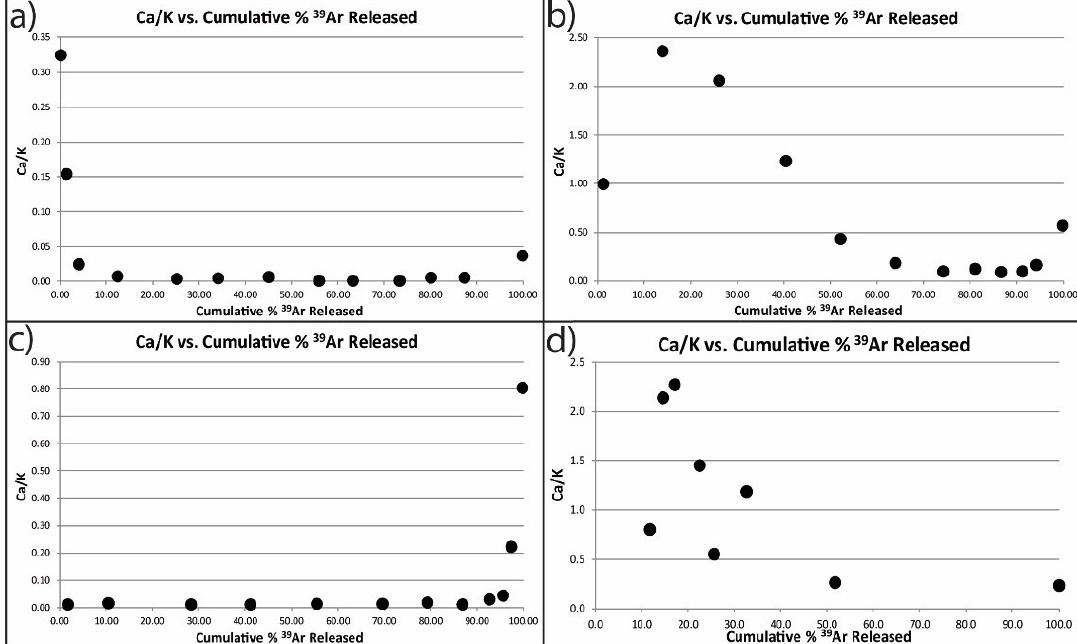
Figure 23. Graphs of Ca/K ratios versus the cumulative percentage of 39 Ar released in each step the of samples of muscovite from the sericitic alteration surrounding the gold-bearing quartz–carbonate vein from samples ( a ) LG-80-33-1848; ( b ) 03-LG-1; ( c ) LG-78-4-143.5 and ( d ) LG-85-3.